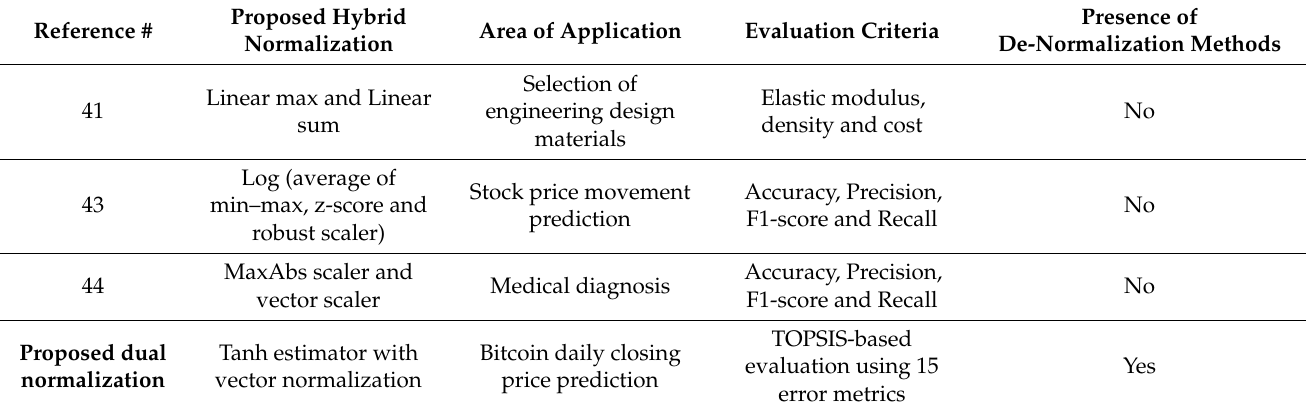
Table 22. Comparison of proposed normalization with available hybrid